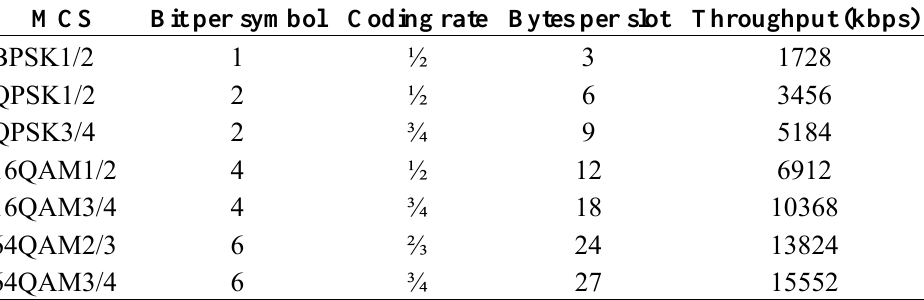
Table 4. Data Throughput Analysis (excluding DCD/UCD)